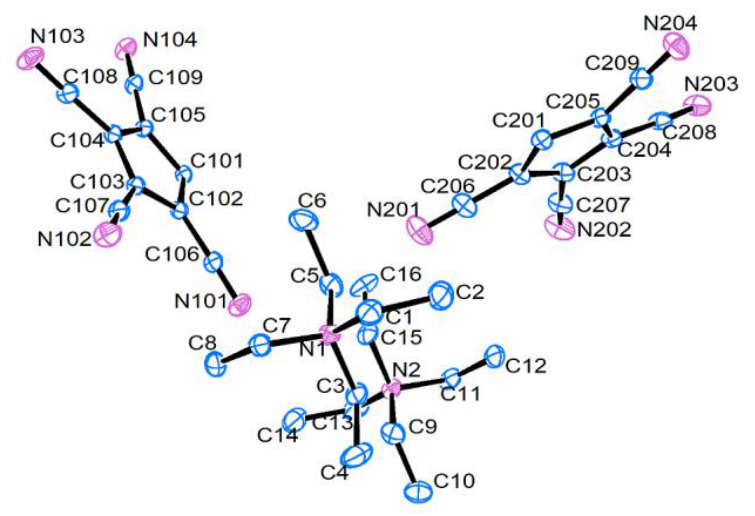
ent half molecules in the unit cell. Figure 9 shows an ORTEP 3 plot of the asymmetric unit. Figure 9. The asymmetric unit of compound 5 . Figure 9. The asymmetric unit of compound 5 .